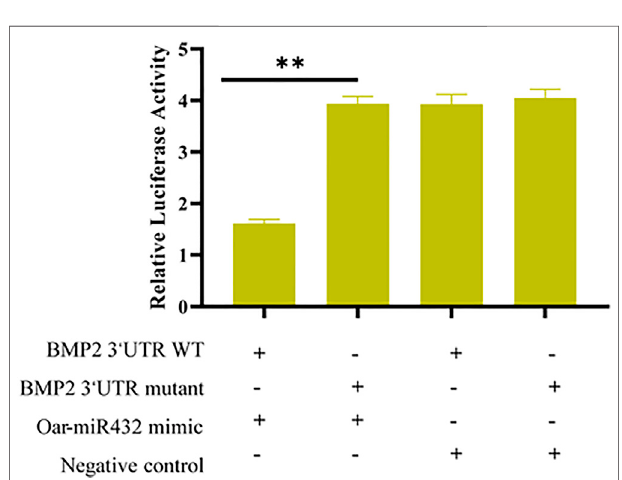
FIGURE4 | Dual-luciferase reporter assay todetect the predicted target gene BMP2 of oar-miR-432.